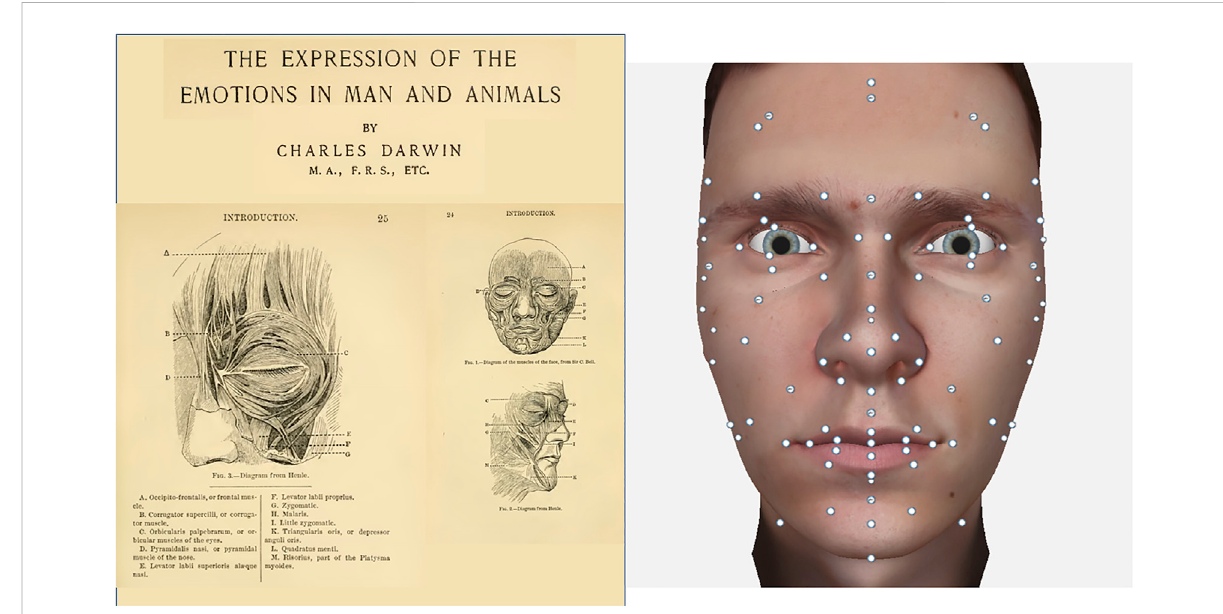
FIGURE 1 On the left, original pictures of Darwin ’ s “ the expression of the emotions in man an animals ” in 1872; on the right, an example of embodied conversational agents with the action units presented on the neutral model, offering to be activated with several intensity (Courgeon et al., 2008; Courgeon and Clavel,